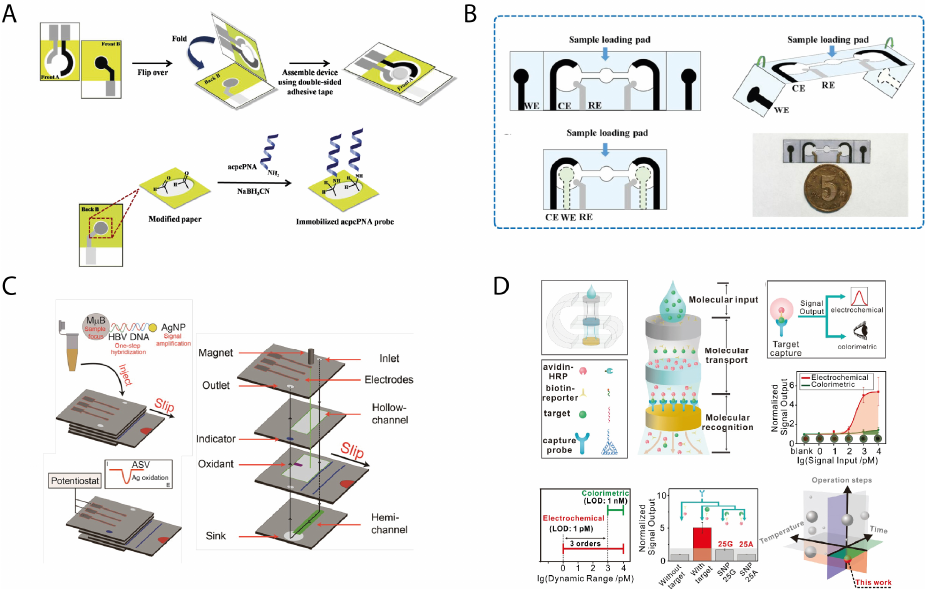
Figure 2. ( A ) Electrochemical impedance-based DNA sensor using pyrrolidinyl peptide nucleic acids for tuberculosis detection. Reprinted with permission from [34], 2018 Elsevier; ( B ) microfluidic origami nano-aptasensor for peanut allergen Ara h1 detection. Reprinted with permission from [35], 2021 Elsevier; ( C ) detection of Hepatitis B Virus DNA with a paper electrochemical sensor. Reprinted with permission from [36], 2015 American Chemical Society; ( D ) molecular threading-dependent mass transport in paper origami for single-step electrochemical DNA sensors. Reprinted with permission from [37], 2018 American Chemical Society.